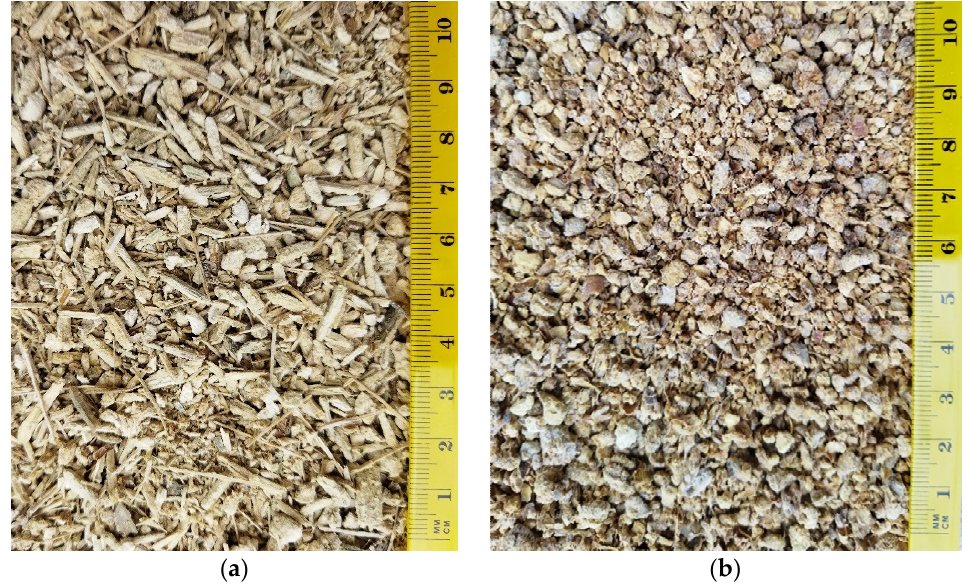
Figure 1. Image of vegetal aggregates: ( a ) sunflower stalks; ( b ) corn cobs.